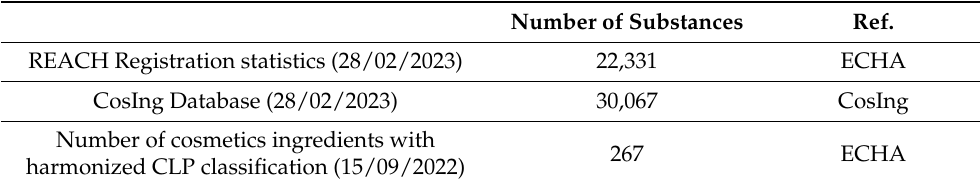
Table 4. Skin sensitiser regulatory statuses from a chemical and cosmetics legislation perspective (the date when the detailed information was gathered is presented in brackets).